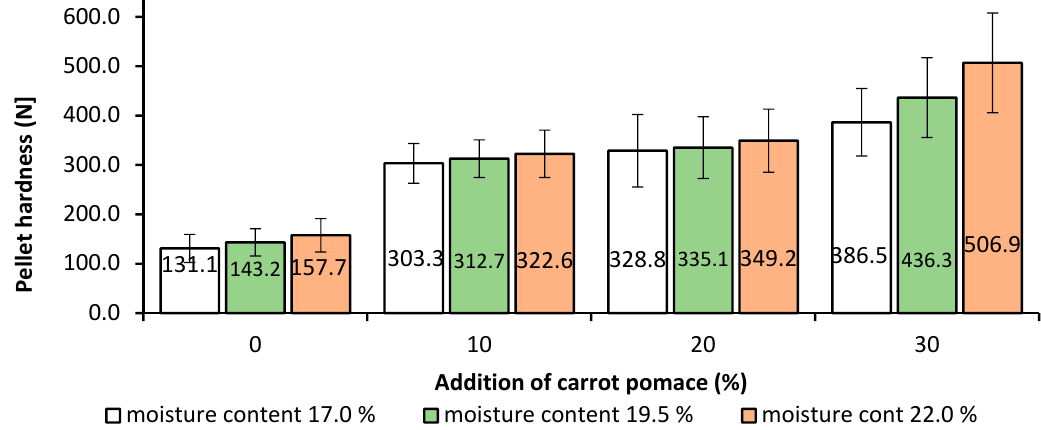
Figure 5. Influence of the contribution of carrot pomace in the mix with barley straw and mix moisture content on the hardness of the obtained pellet.